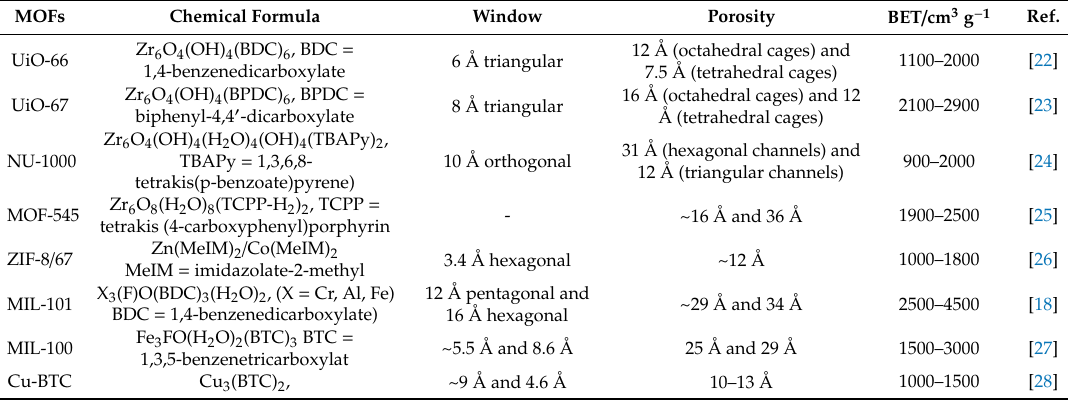
Table 1. Physical properties of representative metal–organic frameworks (MOFs) used to encapsulate polyoxometalates (POMs) for